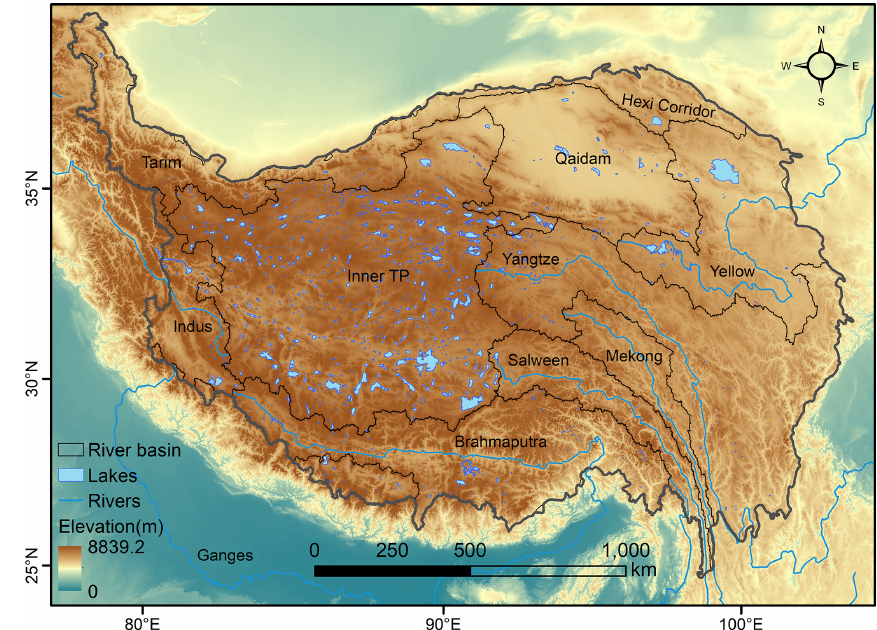
Figure 1. The spatial distribution of lakes on the Tibetan Plateau.